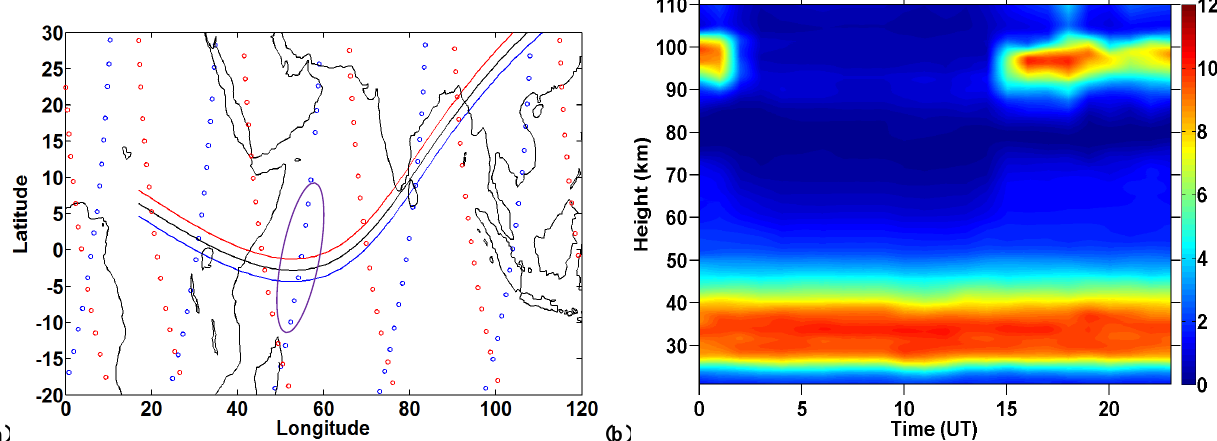
Fig. 1. (a) Path of annular solar eclipse of 15 January 2010 along with TIMED/SABER ascending (blue) and descending (red) orbits. The ellipse indicates the regions chosen for the present study and (b) Composite diurnal variation of ozone mixing ratio in the stratosphere and MLT region constructed using the SABER observations ozone during the winter of